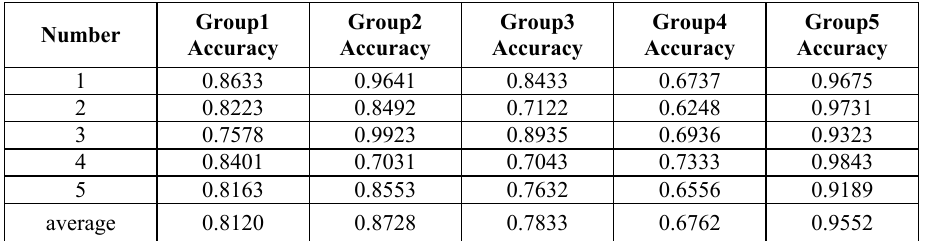
Table 1. 15-3 Forecast accuracy rate